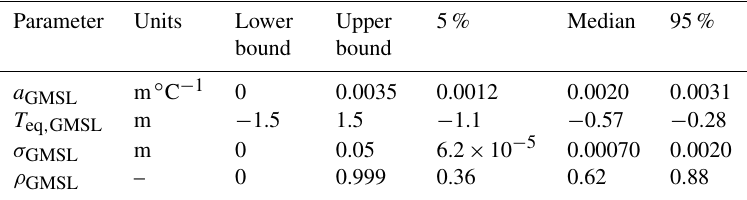
Table A7. Prior probability distribution ranges for the Rahmstorf (2007) global mean sea-level model parameters, and the median, 5th, and 95th quantiles of the calibrated posterior parameter distri- butions. The priors are all uniformly